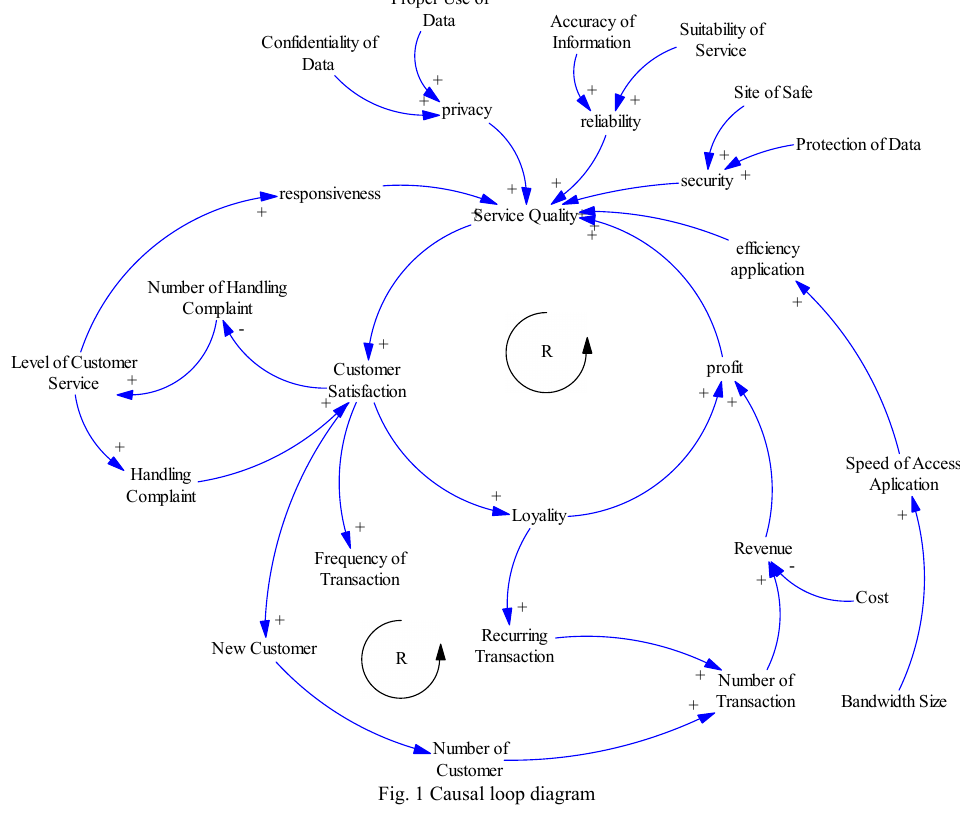
Fig. 1 Causal loop